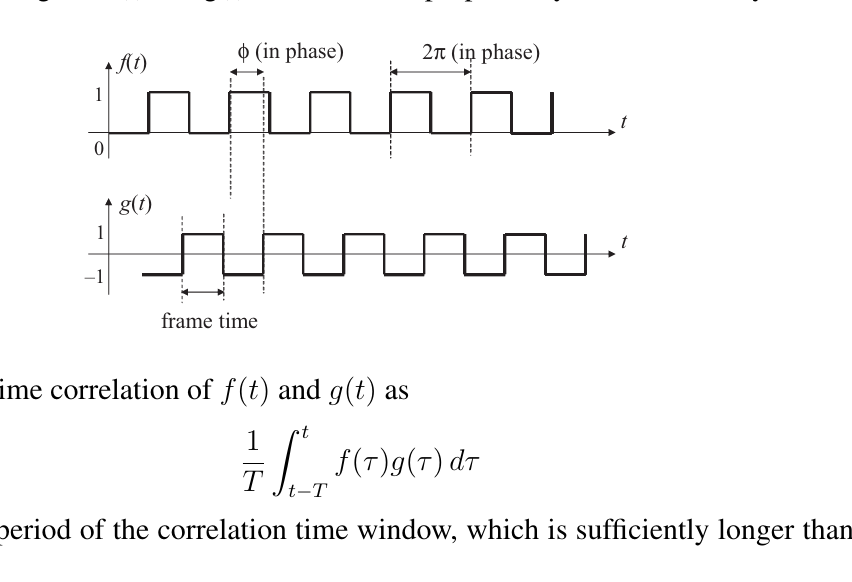
Figure 5. Signals f(t) and g(t) defined in the proposed synchronization